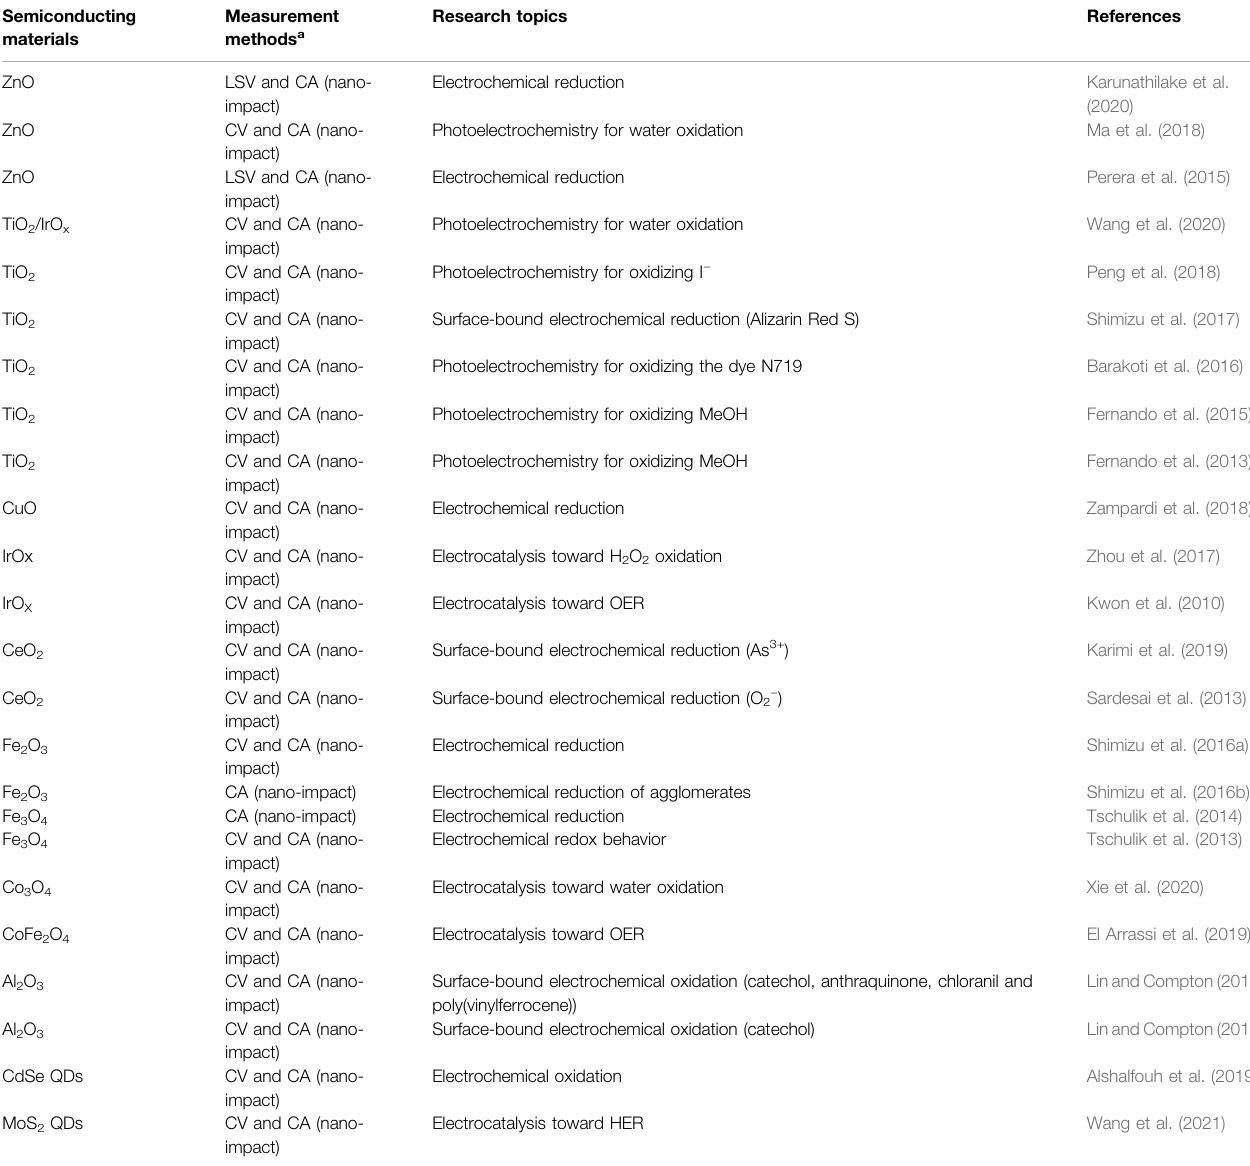
TABLE 1 | Literature on single entity electrochemistry and photoelectrochemistry of semiconducting nanoparticles based on the nano-impact